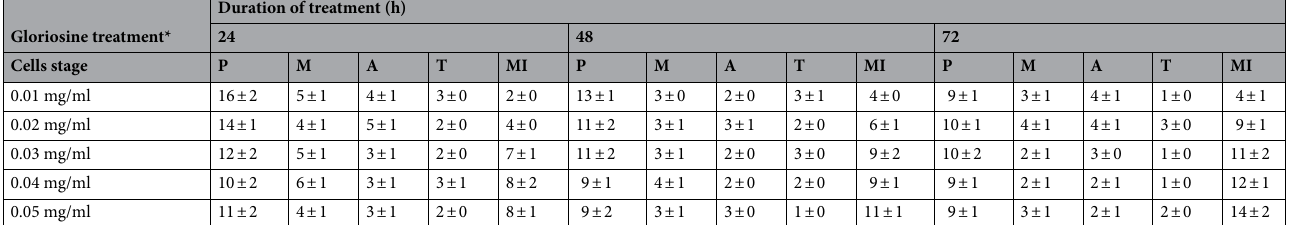
Table 4. Anti-mitotic activity of isolated gloriosine (Iso 2) from elite germplasm of Gloriosa superba . Values are mean (n = 3) ± S.D. P prophase, M metaphase, A anaphase, T telophase, MI mitotic inhibition.